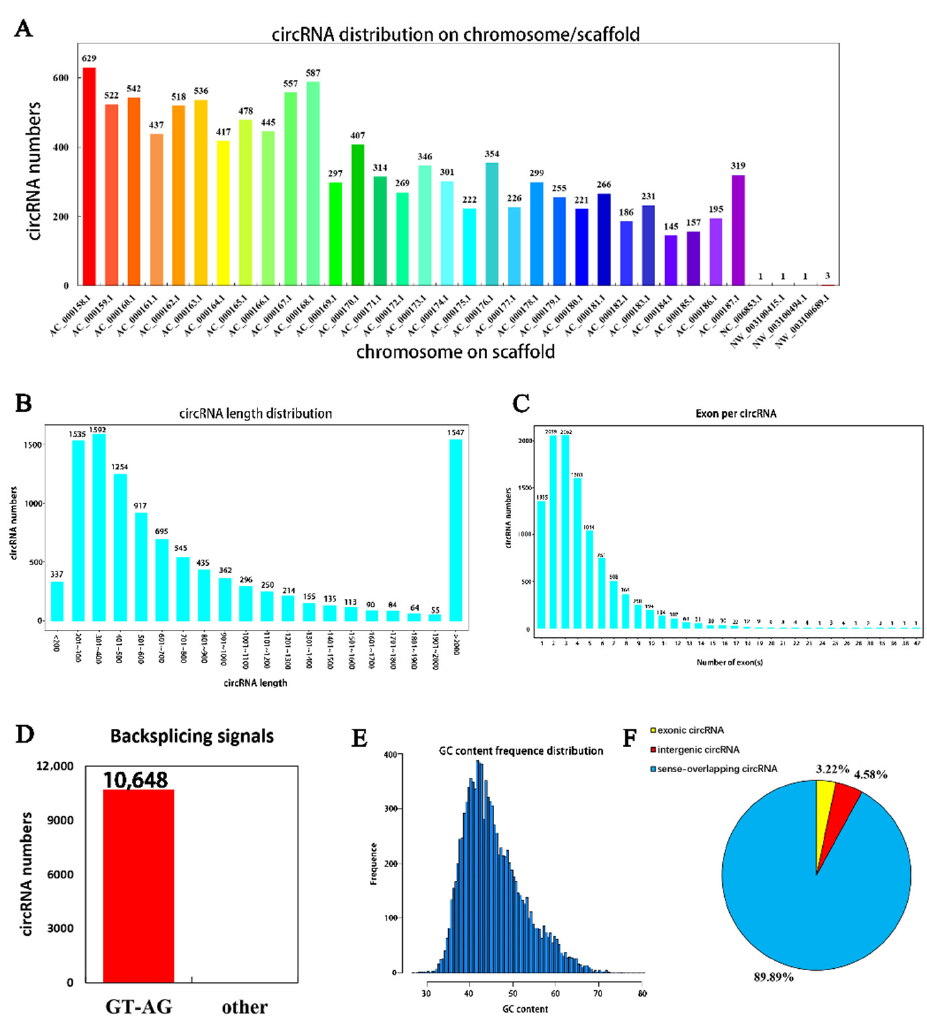
Figure 2. Identification, characterization and chromosomal distribution of circRNAs. ( A ) The number of circRNAs per chromosome; ( B ) the length distribution density of circRNAs); ( C ) the number of exons by circRNAs; ( D ) statistical diagram of circRNA shear signal, with the number of circRNAs on the vertical axis and the type of shear signal on the horizontal axis (specific data are presented in the Supplementary Materials, Table S1); ( E ) the vertical axis is the number of circRNAs and the horizontal axis shows the CG content of circRNAs; ( F ) percentage of different types of circRNAs.